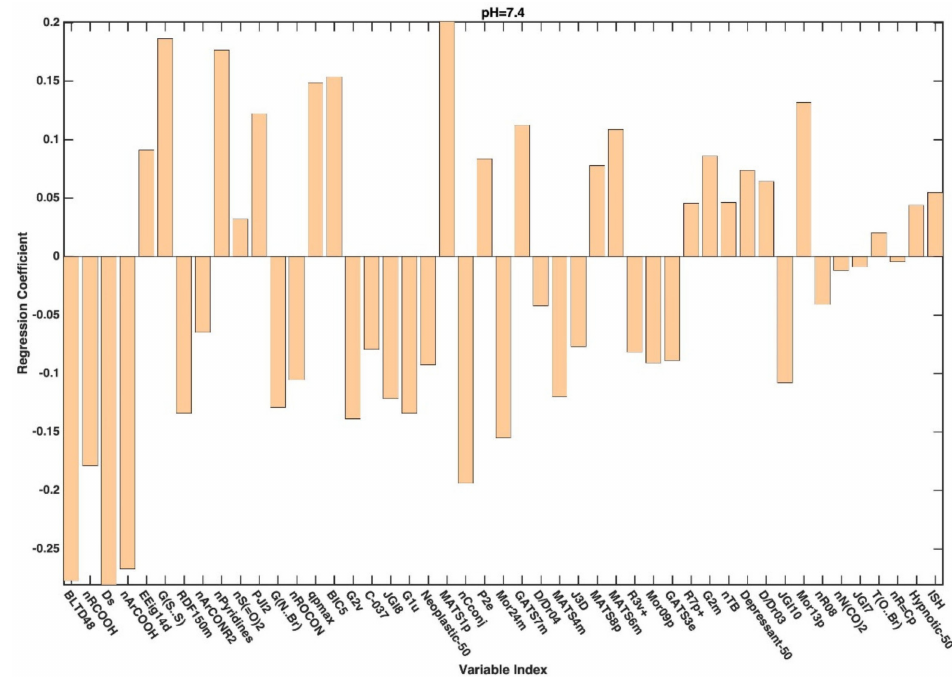
Figure A3. Regression coefficients associated to the descriptors selected by CovSel for the PLS-DA model based on the reduced dataset collected at pH 7.4.